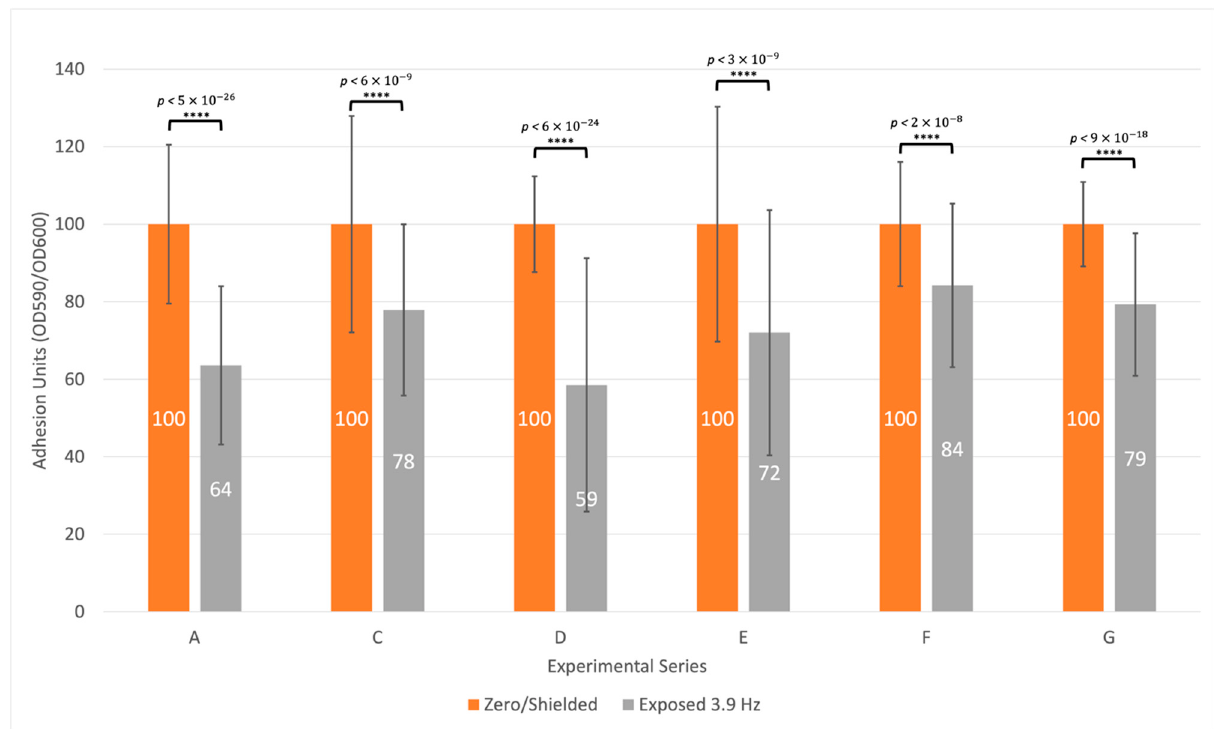
Figure 4. Effect of shielded vs. exposed conditions on biofilm adhesion units (ratios of OD590/OD600) normalized to control condition “Zero/Shielded”. Data points from six experimental series (A–G) are shown at two different conditions: “Zero/shielded” and “Exposed/3.9 Hz”. Y-axis show normalized values relative to the “Zero/shielded” condition (value 100). Standard deviation for each microtiter plate and statistical p -values (paired t-test) are indicated (**** signifies p < 0.0001).